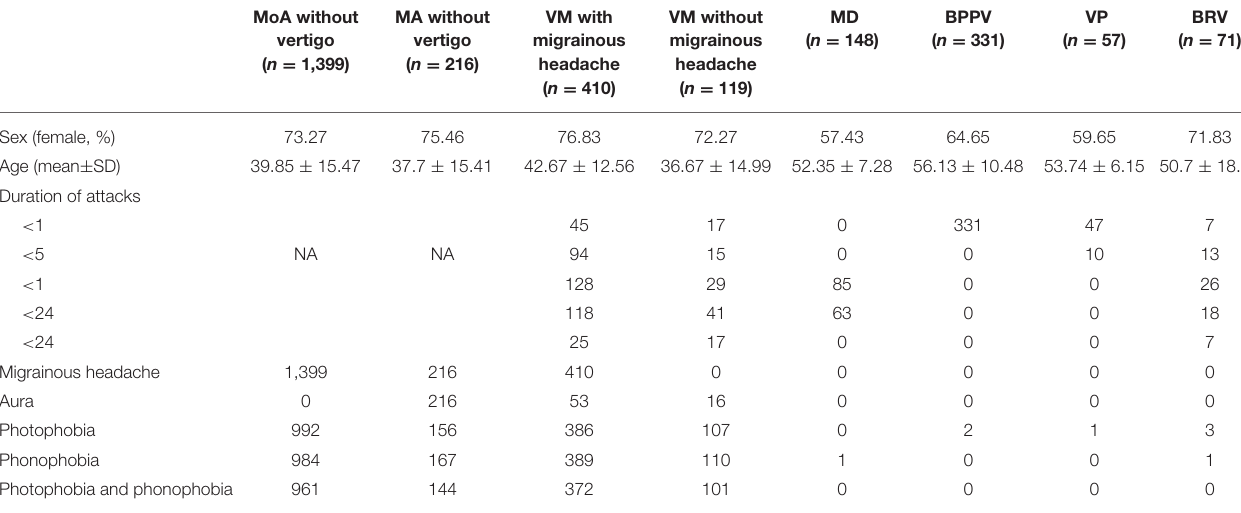
TABLE 2 | Demographic and clinical characteristics of patients at